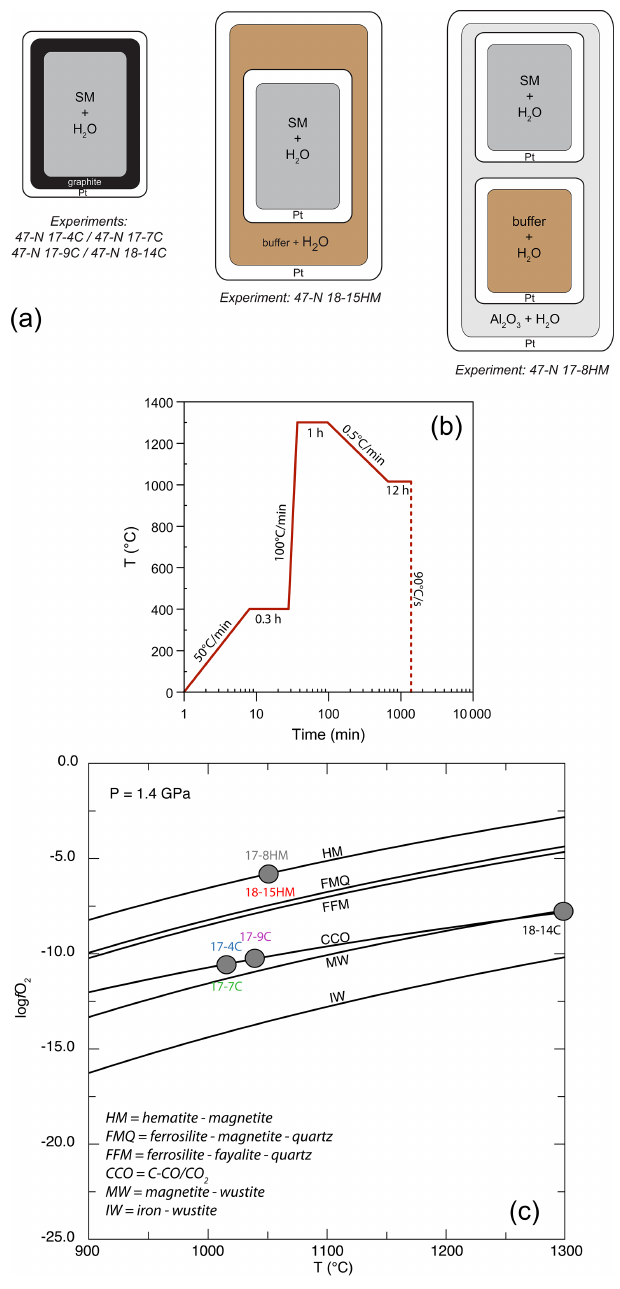
Figure 1. (a) Single-, double-, and triple-capsule design used in crystallization experiments; SM is “starting material”. (b) Temper- ature vs. time path of the experiments. (c) Temperature vs. log f O 2 diagram at fixed pressure of 1.4GPa reporting the different exper- imental runs (see Table 2 for more information). The solid lines represent f O 2 conditions by adopting different buffers. Calculating f O 2 was achieved using the Perple_X software (Connolly,